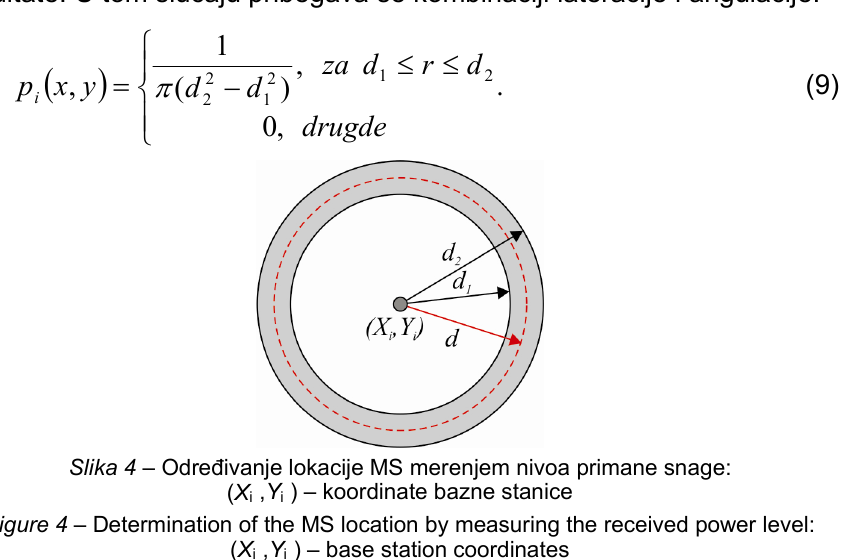
Figure 4 – Determination of the MS location by measuring the received power level: ( X i , Y i ) – base station coordinates Osnovne karakteristike UMTS standarda Mobilni radio-sistemi tre ć e generacije (3G) zasnivaju se na CDMA